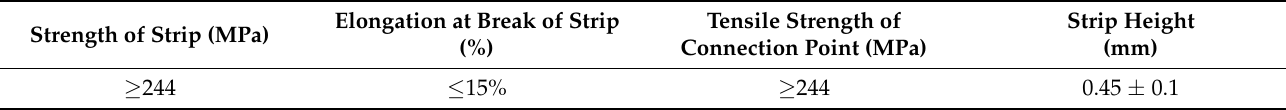
Table 2. Performance indicators of